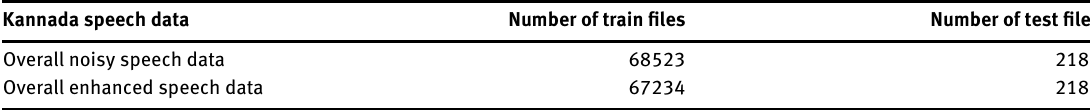
Table 17: The Speech Files Used for System Training and Testing.